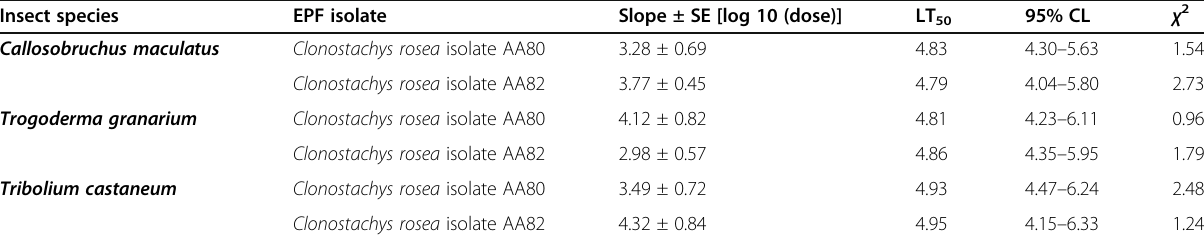
Table 2 Median lethal time (LT 50 ) of two isolates of Clonostachys rosea against adult stage of Callosobruchus maculatus , Trogoderma granarium and Tribolium castaneum . The conidial concentration of each entomopathogenic fungal isolate used for treatment was